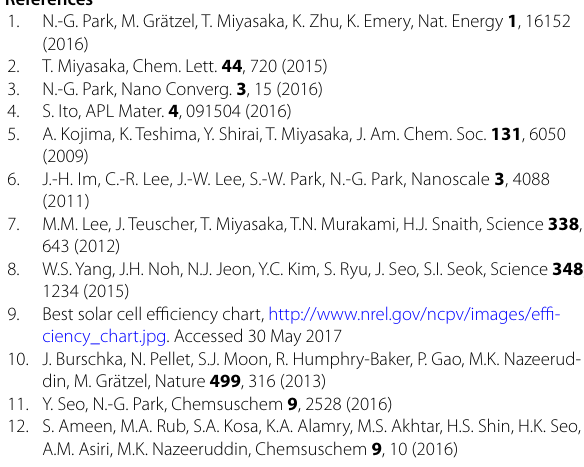
Scan direction: forward J SC